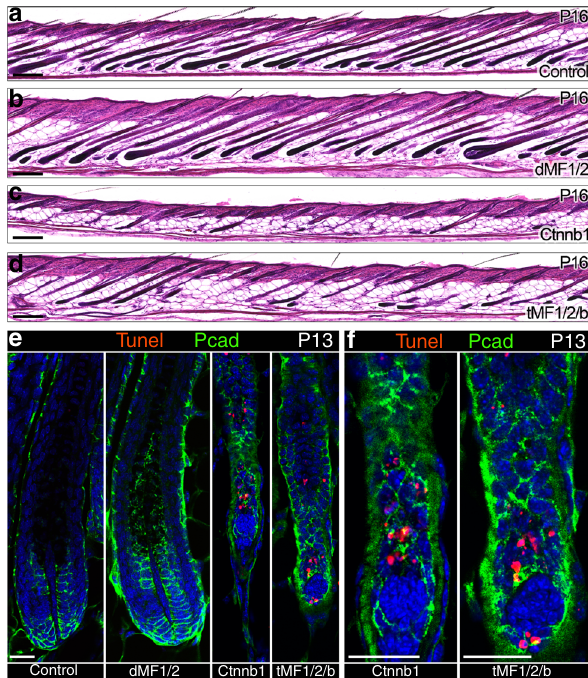
Fig. 7 Concomitant ablation of Fgfr1, Fgfr2, and beta-catenin speci fi cally in the DP results in premature induction of catagen. a – d HE staining of skin sections from control, dMF1/2, Ctnnb1, and tMF1/2/b mice at P16 is shown. Note the unsynchronized nature of catagen in both Ctnnb1 and tMF1/2/b mutant mice. n > 3 mice per genotype. e Tunel staining of P13 skin sections from control, dMF1/2 double mutant, Ctnnb1 mutant, and tMF1/2/b triple mutant is shown to illustrate the normal apoptosis around the DP during the premature catagen. Pcad immunostaining was also included to outline the DP. Nuclei are in blue (DAPI). n = 3 mice per genotype. f Higher magni fi cations of the fi elds surrounding the DP of Ctnnb1 and tMF1/2/b mutant follicles in e are displayed. Scale bar in ( a – d ), 200 μ m. Scale bar in ( e , f ), 25 μ